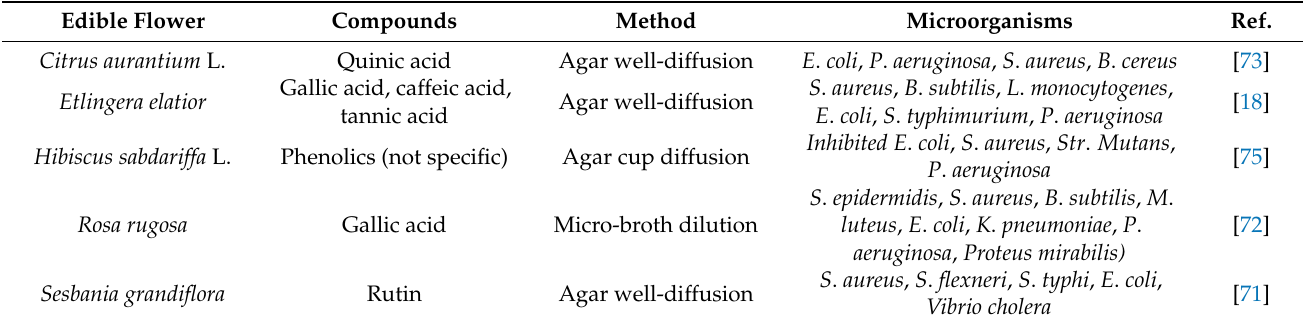
Table 4. Antimicrobial activities in edible